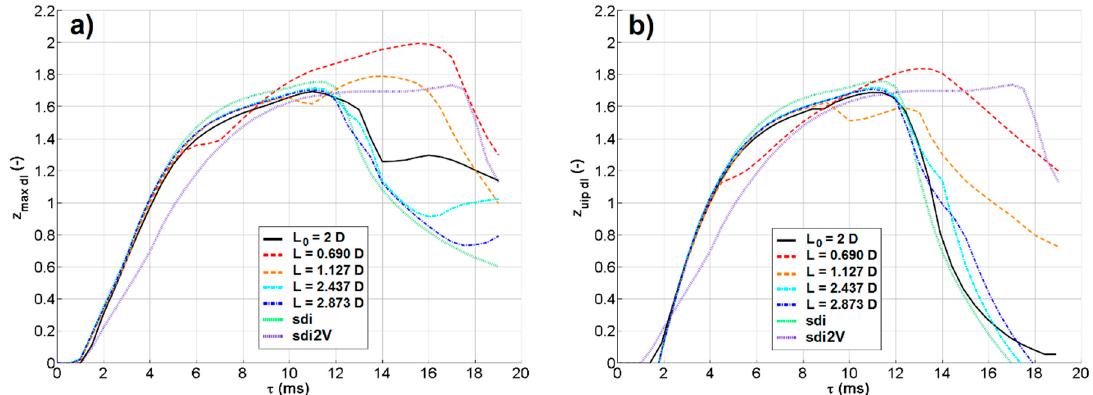
Figure 10. Time evolution of z max dl ( a ) and z uip dl ( b ) as a function of the distance L between the drops. Reference case (L 0 / D = 2) is case B; the other cases are with the drop interspace decreased and increased by 1 mm and 2 mm. Single drop impact (sdi) includes the same drop diameter and impact velocity; the single drop impact for a drop with the same impact velocity but a volume and mass double of the original one (sdi2V) is also added.